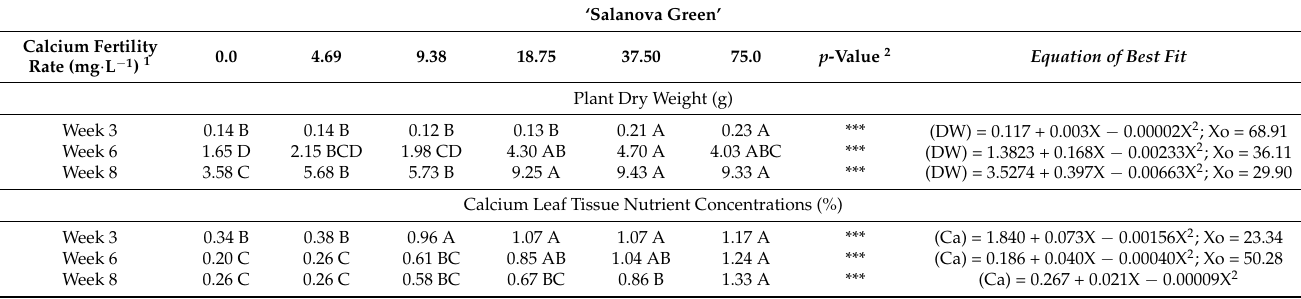
Table 5. Impact of calcium fertility rate on plant dry weight and calcium leaf tissue concentration on ‘Salanova Green’ lettuce. ‘Salanova